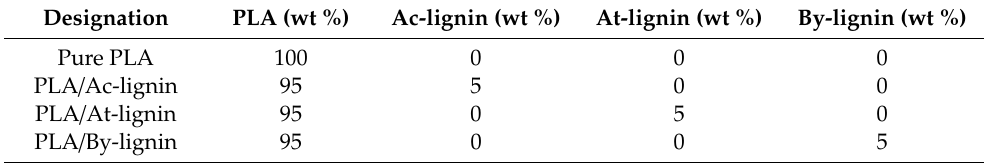
Table 1. Composition of PLA/Ac-lignin, PLA/At-lignin, and PLA/By-lignin biocomposites.